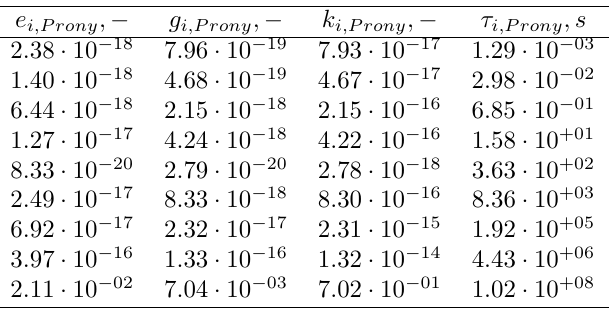
Table 2. Prony parameters: Ninjaflex ® .